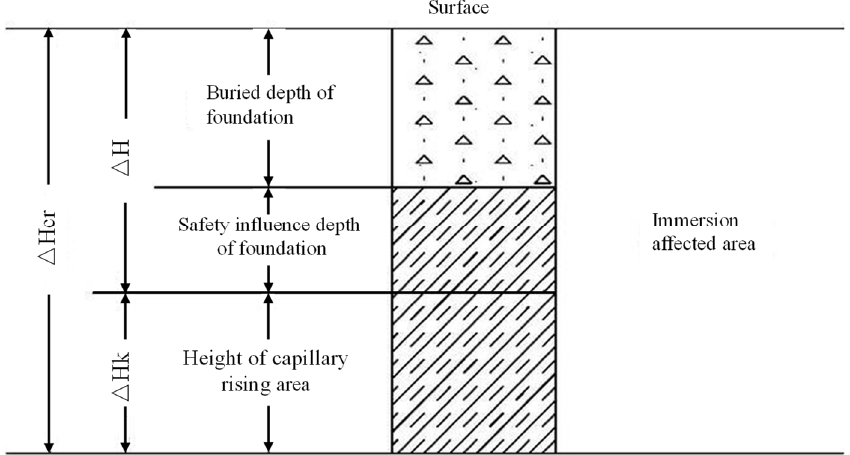
Figure 5. Schematic diagram of immersion critical groundwater depth (Hcr) in the construction area.